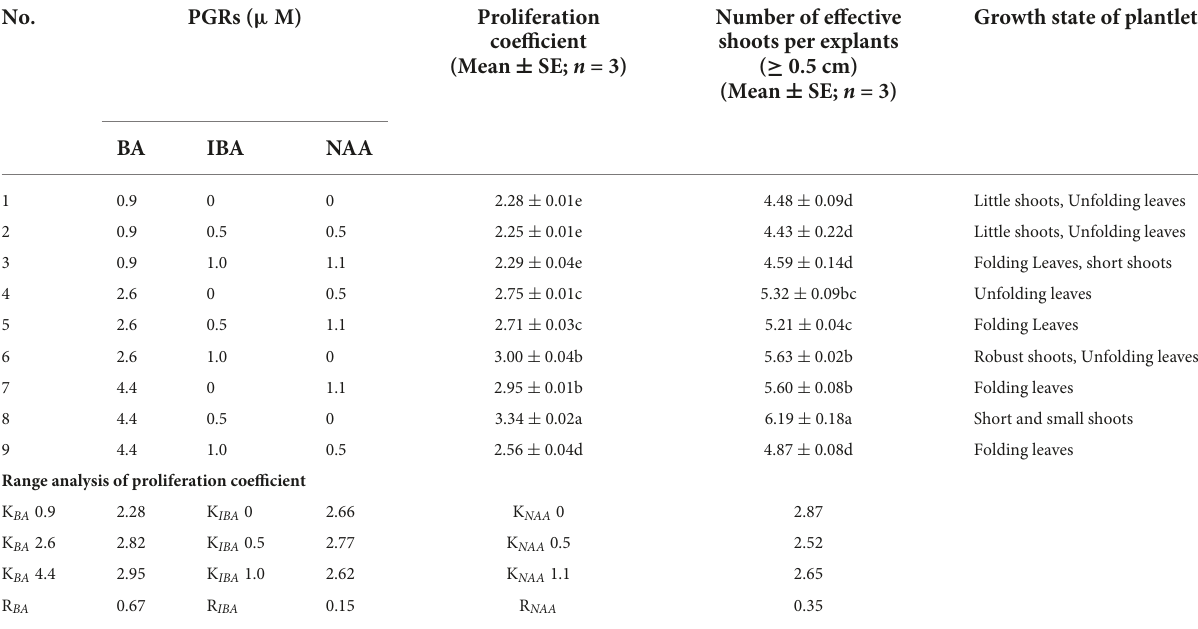
TABLE 4 Effects of different concentrations and compositions of BA, IBA, and NAA on shoot proliferation, and range analysis. No. PGRs ( µ M) Proliferation